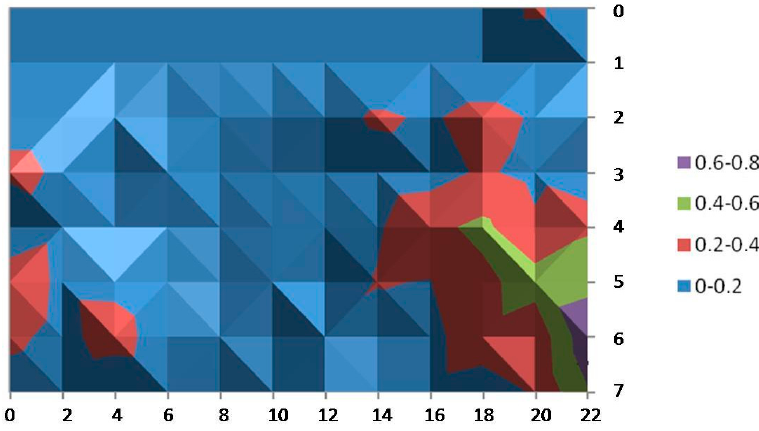
Figure 7. Average error for the x-coordinate.